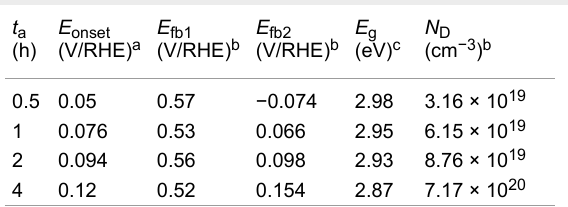
Table 3: Experimental and calculated values from PEC measure- ments for TNTs as a function of t a